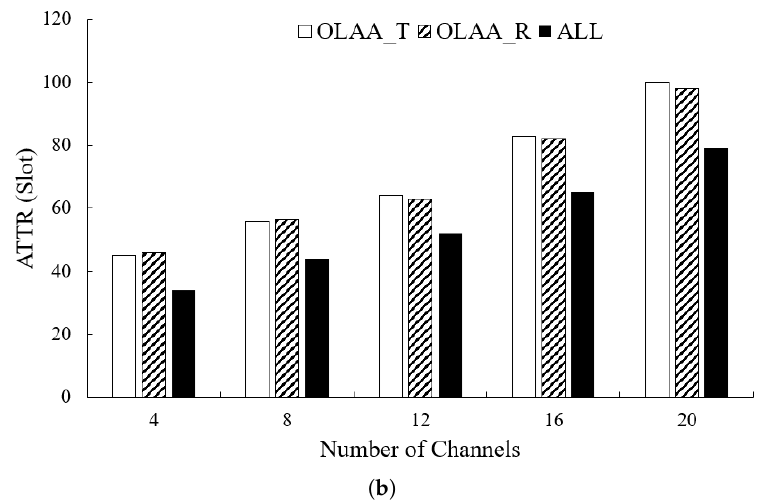
Figure 9. This figure displays the impact of the number of channels on the bottleneck topology’s performance in an asynchronous network, as measured by two metrics: ( a ) throughput and ( b ) ATTR.